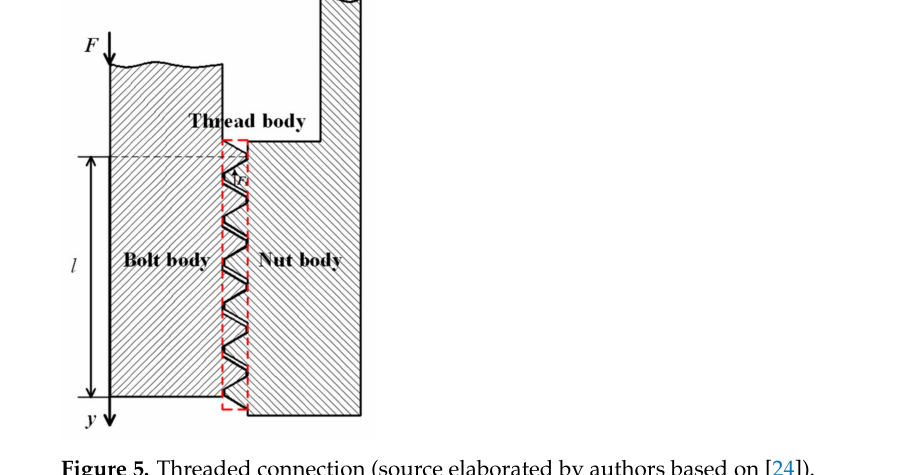
Figure 5. Threaded connection (source elaborated by authors based on [24]).